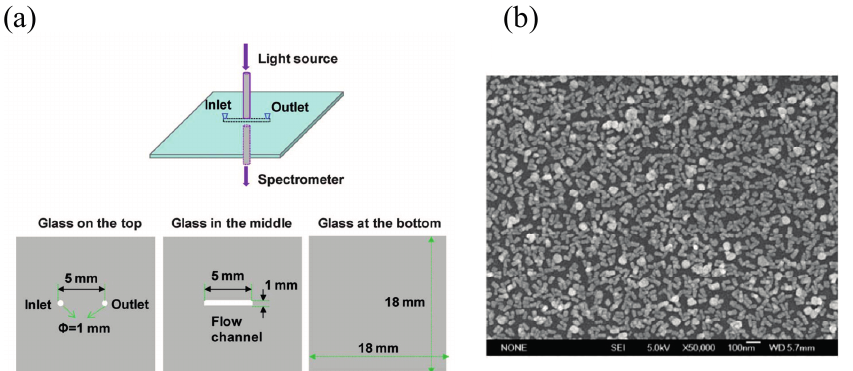
Figure 3. ( a ) Schematic of the LSPR sensing system with the microfluidic device